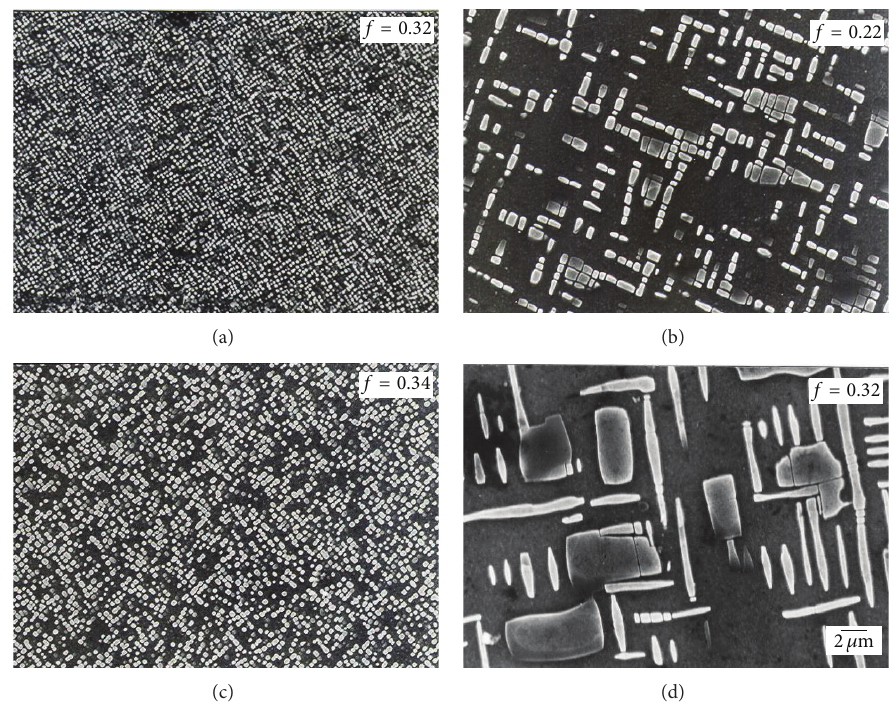
Figure 1: SEM micrographs of the Fe 0.75 Ni 0.10 Al 0.15 alloy aged at (a-b) 750 and (c-d) 950 ∘ C for 50 and 200 h, respectively.